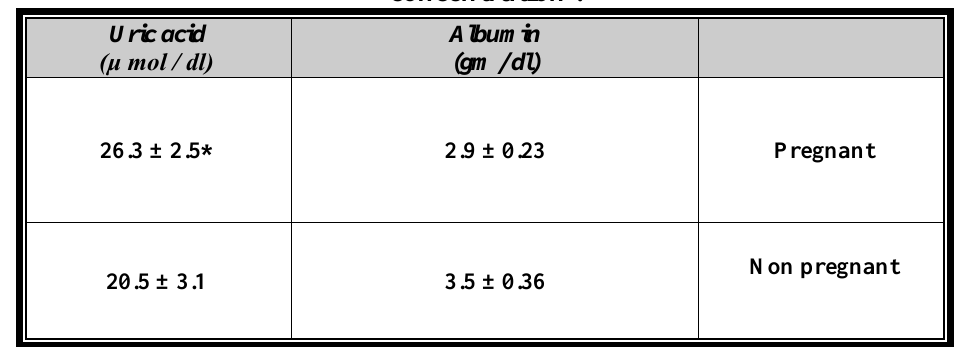
Table (2) the effect of pregnancy on antioxidants (albumin and uric acid) concentration